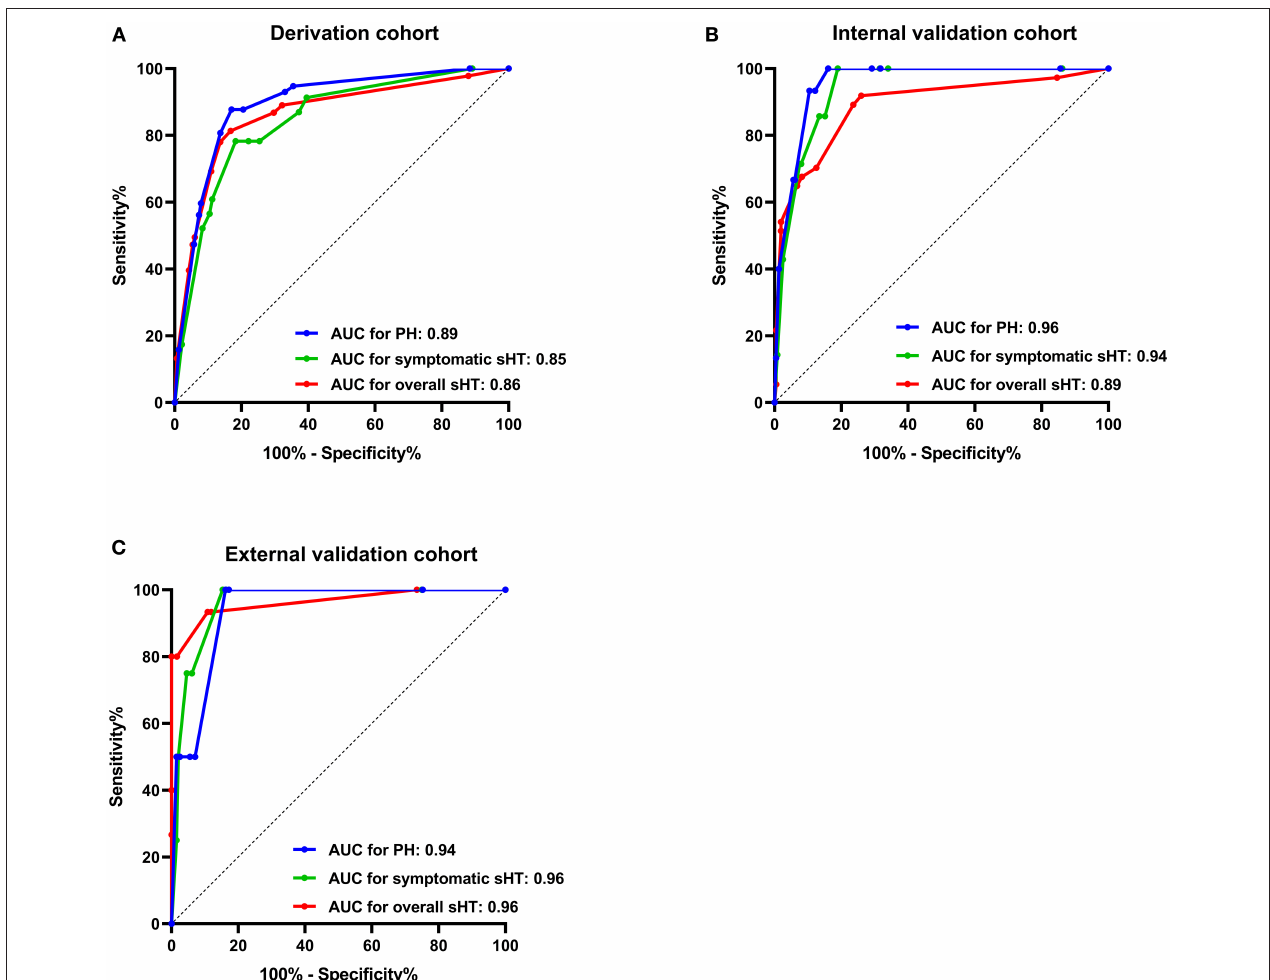
FIGURE 1 | AUC of the SHAIS score for predicting sHT in the derivation cohort (A) , the internal validation cohort (B) , and the external validation cohort (C) . AUC, area under the receiver-operating characteristic curve; sHT, spontaneous hemorrhagic transformation; PH, parenchymal